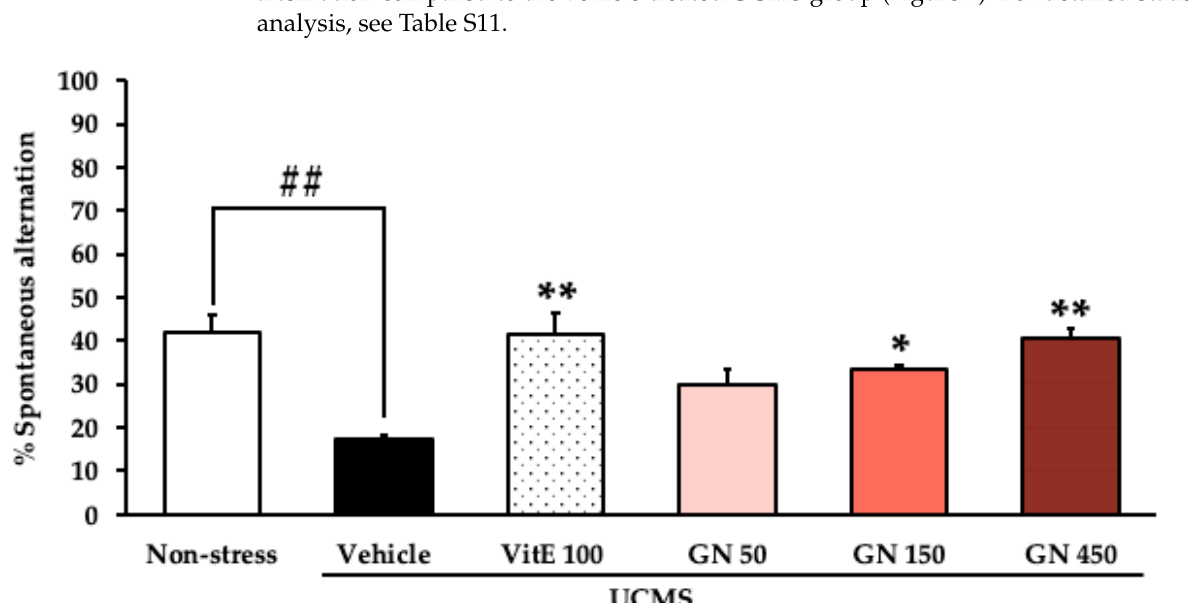
Figure 2. The effect of the GN bark resin extract on learning and memory in the Y-maze test. Each column represents the mean ± SEM ( n = 10–11). ## p < 0.001 vs. the vehicle-treated non-stress group. * p < 0.05, ** p < 0.001 vs. the vehicle-treated UCMS (post-hoc Tukey test).